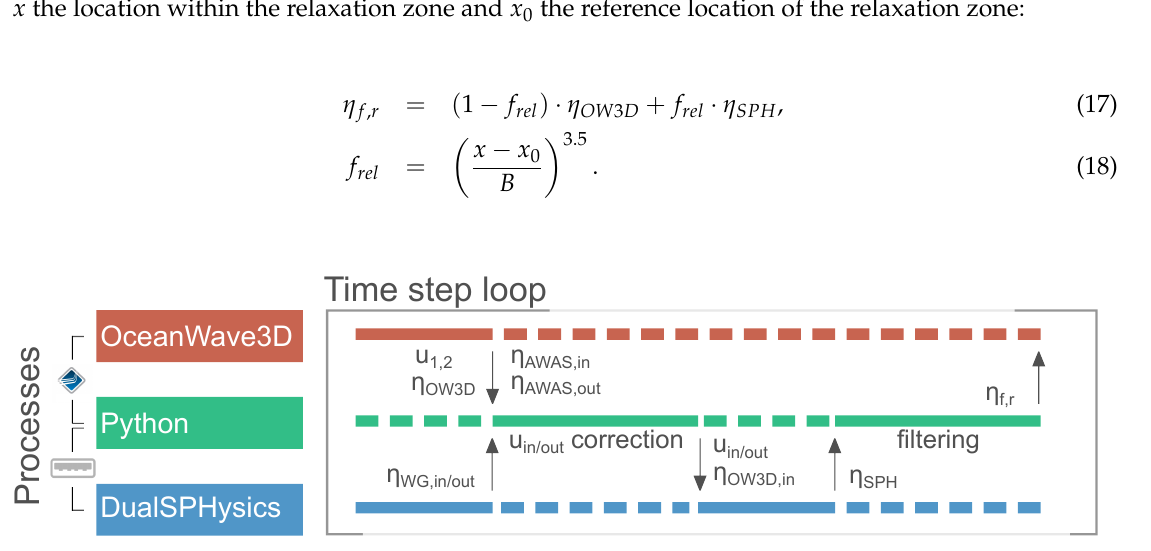
Figure 6. Schematic representation of the coupling algorithm during one communication time step.